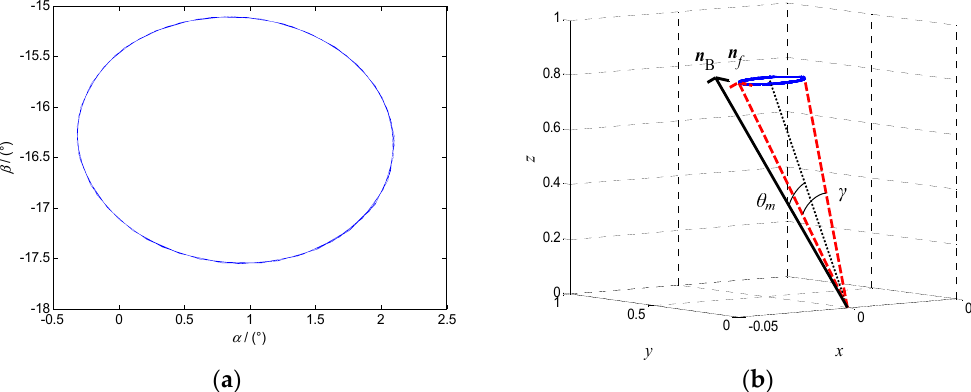
Figure 10. Periodic motion of the DSCR with ω = 18 π rad/s, B = 7 mT, l = − 2 mm. ( a ) The steady phase diagram of the system; ( b ) The precession of the polar axis n f .